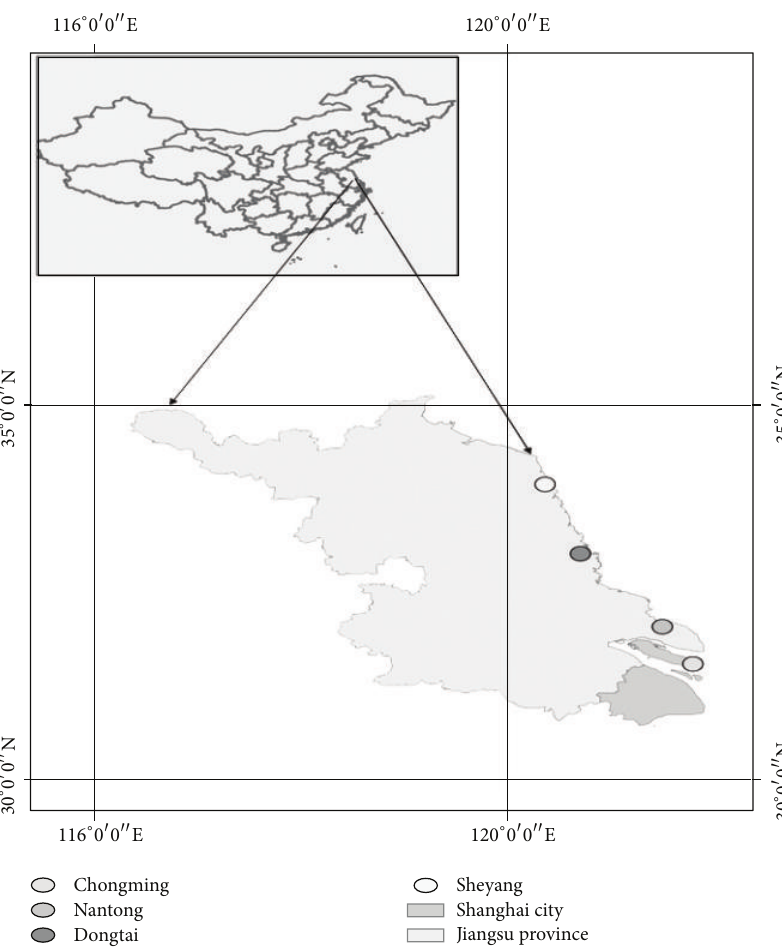
Figure 1: Locations of different sampling